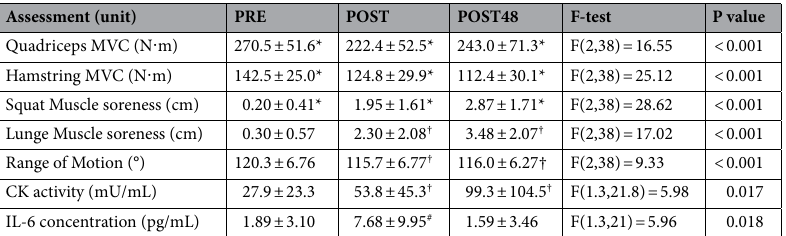
Kinematics (unit) PRE POST